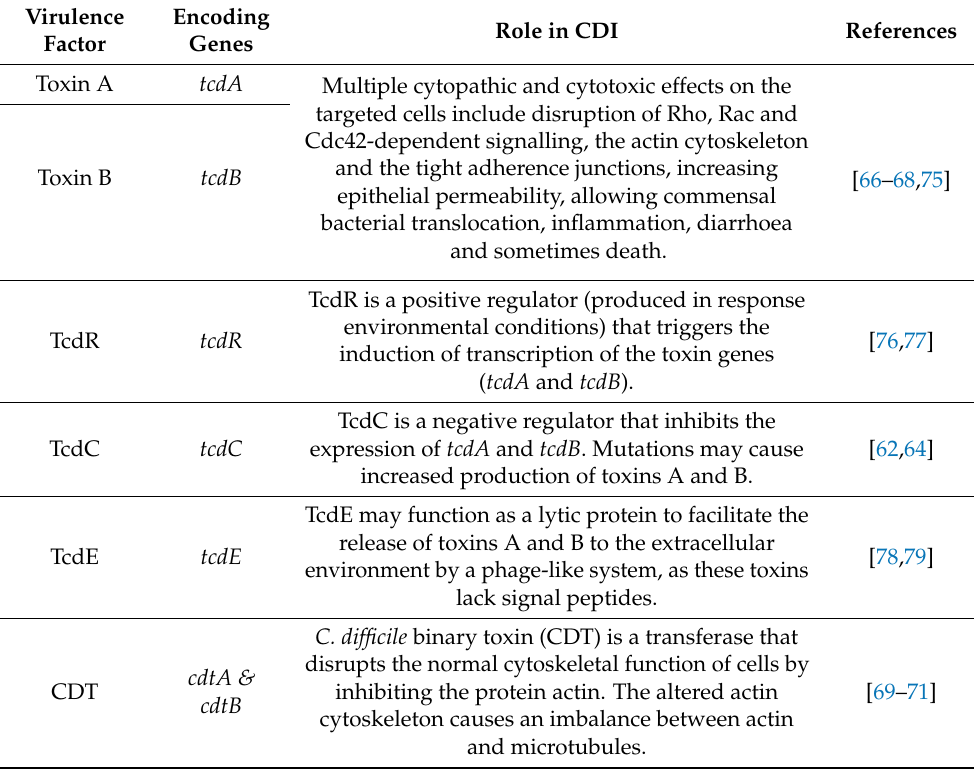
Table 1. The virulence factors in C. difficile and their